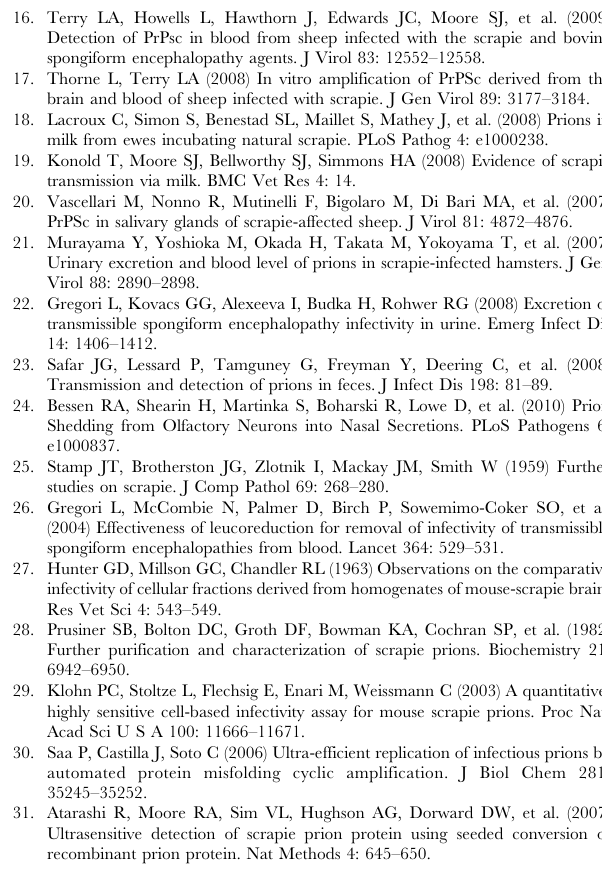
data points show the average ThT fluorescence of 4 and 8 replicate wells respectively.